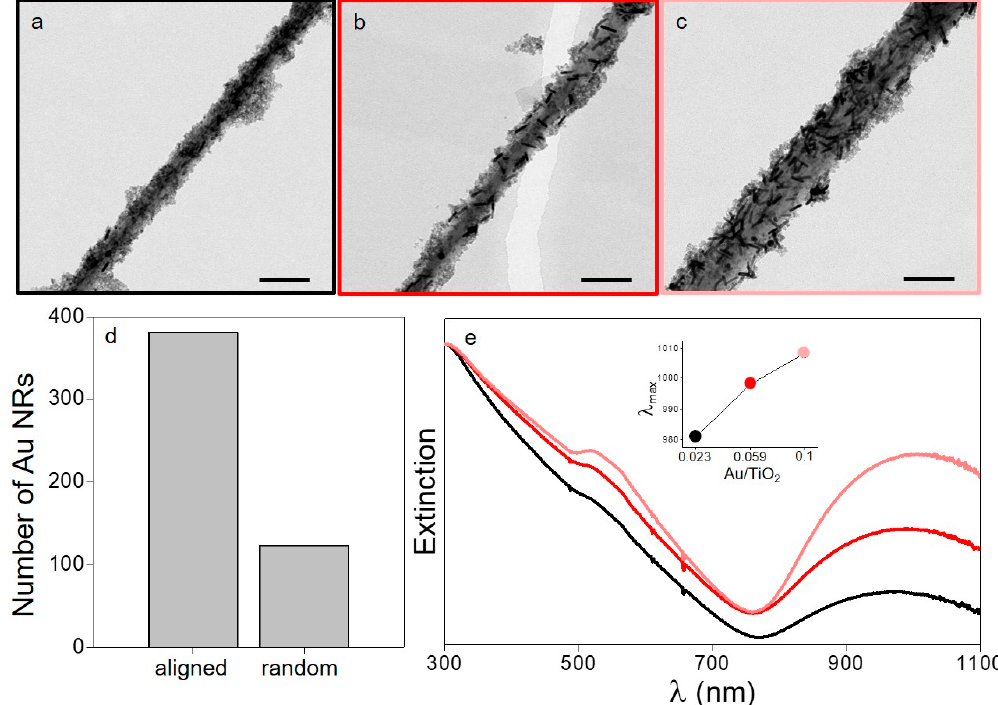
Figure 2. Structural and optical characterization of the titanate nanowires functionalized with Au NRs and TiO 2 NPs: ( a – c ) TEM images with the di ff erent Au / TiO 2 molar ratios: 0.023, 0.059 and 0.1, respectively (the scale bars represent 200 nm), ( d ) number of aligned and randomly oriented Au NRs observed in the samples (the ratio remains stable for the three di ff erent amounts of Au NRs introduced), and ( e ) extinction spectra of the three samples with di ff erent Au / TiO 2 molar ratios: 0.023 (black), 0.059 (red) and 0.1 (pink) (the inset shows the shift in the longitudinal plasmon band with respect to the increase in concentration of plasmonic nano-objects).